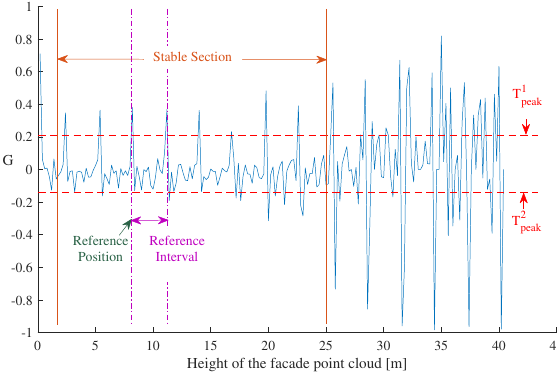
Figure 2. Statistical analysis of gradients G in sliding windows